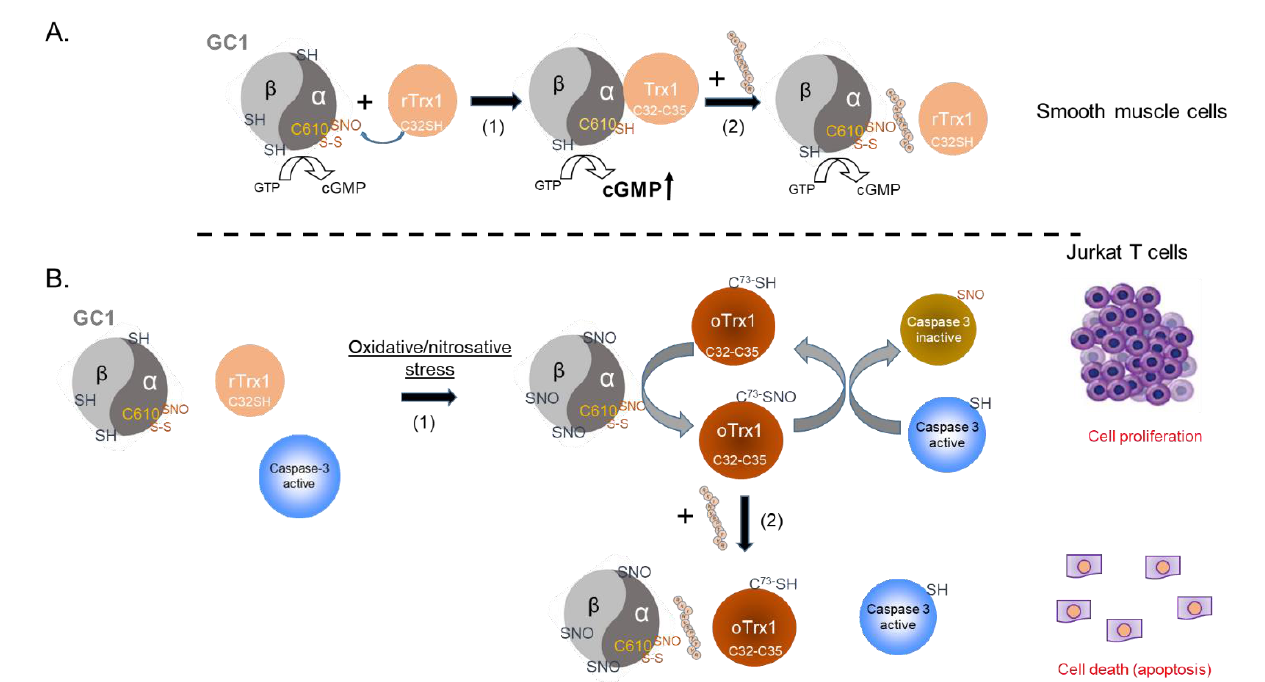
Figure 5. Proposed models of the inhibitory peptide effects on NO-cGMP signaling pathway and SNO transnitrosation cascades. ( A ) Under reducing conditions, in smooth muscle cells for example, rTrx1 and GC1 associate via a mixed disulfide between C610 of the GC1 α subunit and C32 of Trx1 [2] (C610 is endogenously S-nitrosated [25] or/and engaged in a disulfide). In turn, Trx1 increases NO-stimulated GC1 activity thus enhancing the NO-GC1-cGMP pathway (1). Addition of the inhibitory peptide, by blocking the Trx1-GC1 complex formation, blunts Trx1 enhancement of NO- stimulated GC1 activity (2). ( B ) Oxidative and/or nitrosative stress induces multiple S-nitrosation of GC1 and oxidation of Trx1 (oTrx1). In Jurkat T cells, the levels of S-nitrosation are endogenously elevated; a transnitrosation cascade initiated by SNO-GC1 and mediated by oTrx1 leads to caspase-3 S-nitrosation, which renders it inactive leading to cell proliferation (1). In the presence of the inhibitory peptide, SNO-GC1 and oTrx1 interaction is blocked, the transnitrosation cascade is disrupted; thus, caspase 3 remains active, supporting cell death